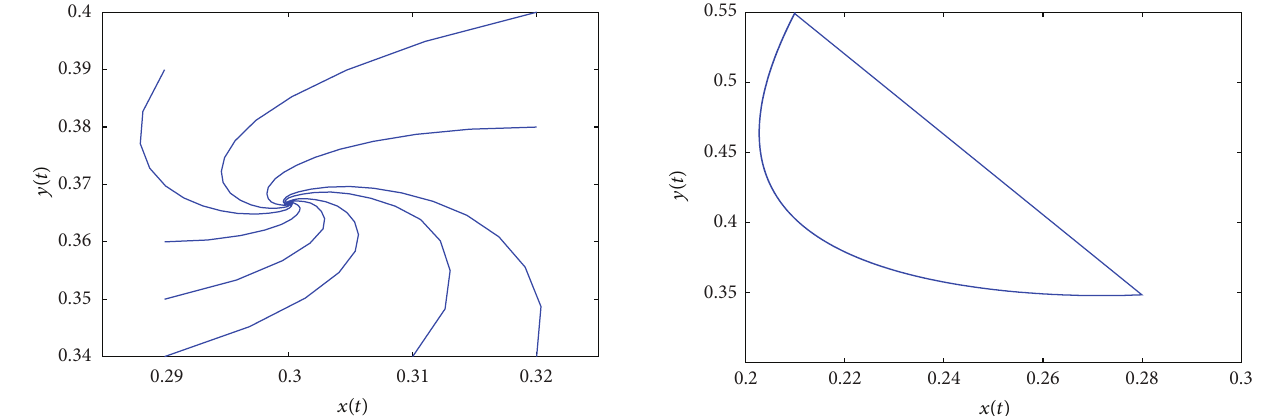
Figure9:Plotofthepositiveperiodicsolutionwhen ℎ 1 < (1−𝛼)ℎ 2 < ℎ